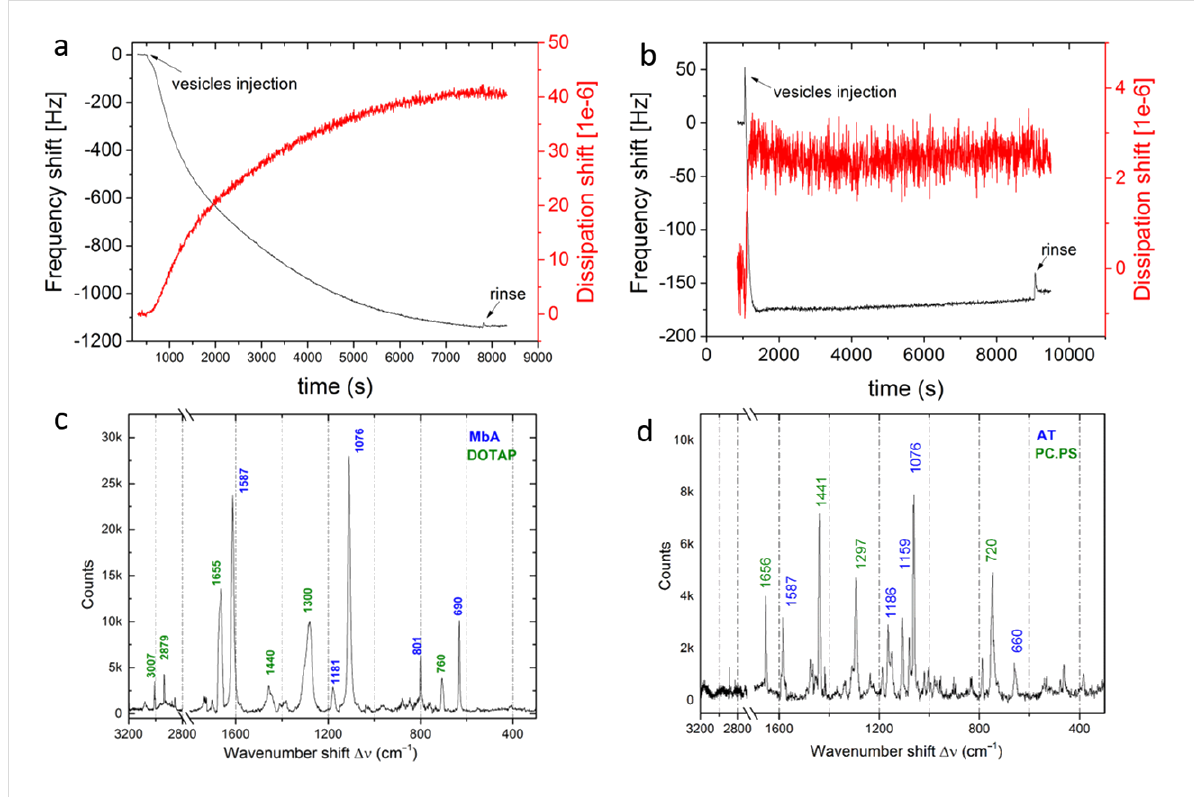
Figure 5: a,b) QCM-D measurements of shift in frequency and dissipation of a) DOTAP on MbA substrate, and b) POPC/POPS on AT substrate; c,d) respective Raman spectra on QCM sensors coated with c) MbA and DOTAP, and d) AT and POPC/POPS blend.